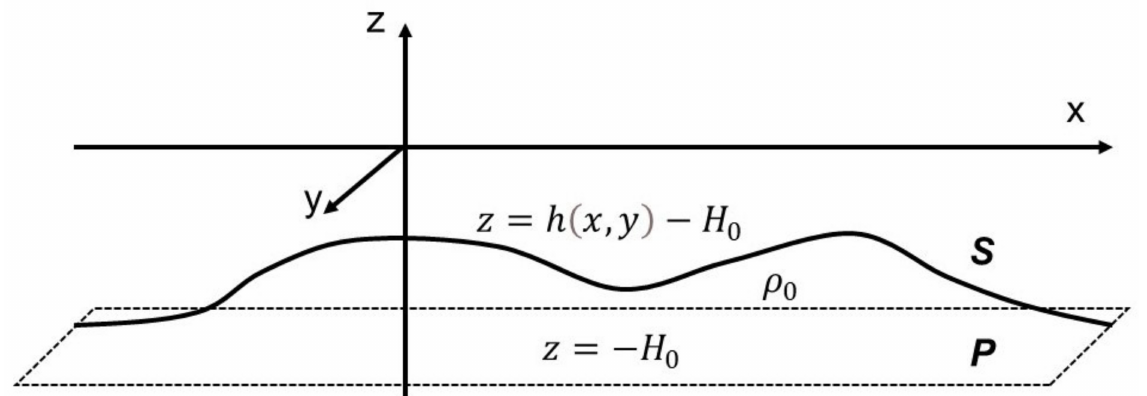
(cid:16) (cid:17) r (cid:48) , h ( x , y ) d z , is a surface integral of ϕ = h ( x , y ) d z over the